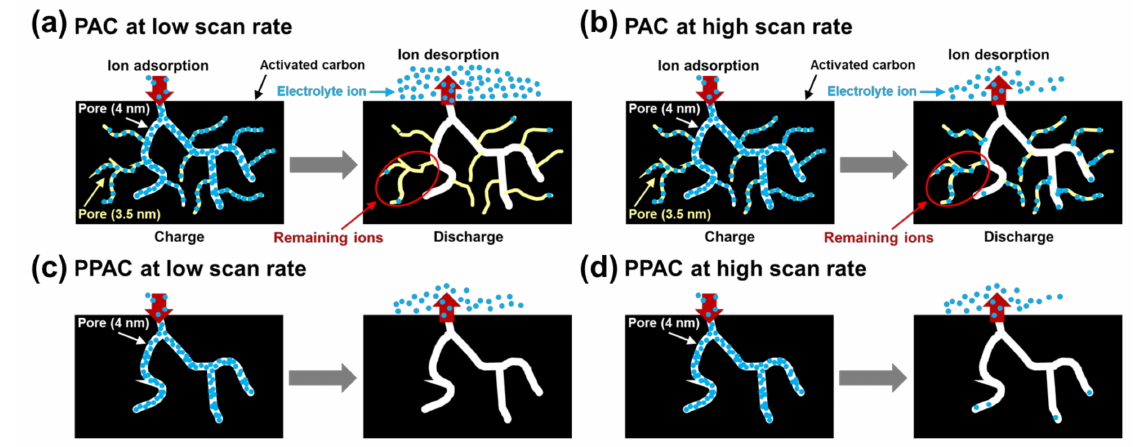
Figure 4. Schematic illustration showing proposed ion storage and expulsion behavior of PAC at ( a ) a low scan rate and ( b ) a high scan rate, and that of PPAC at ( c ) low scan rate and ( d ) high scan